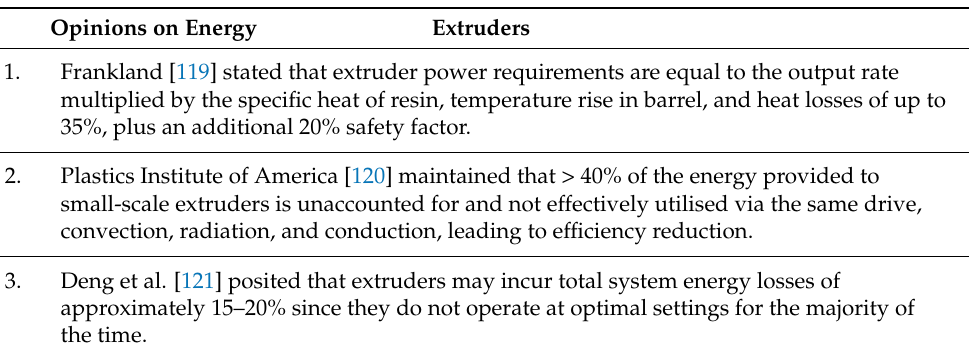
Table 1. Comparison of energy consumption and losses during